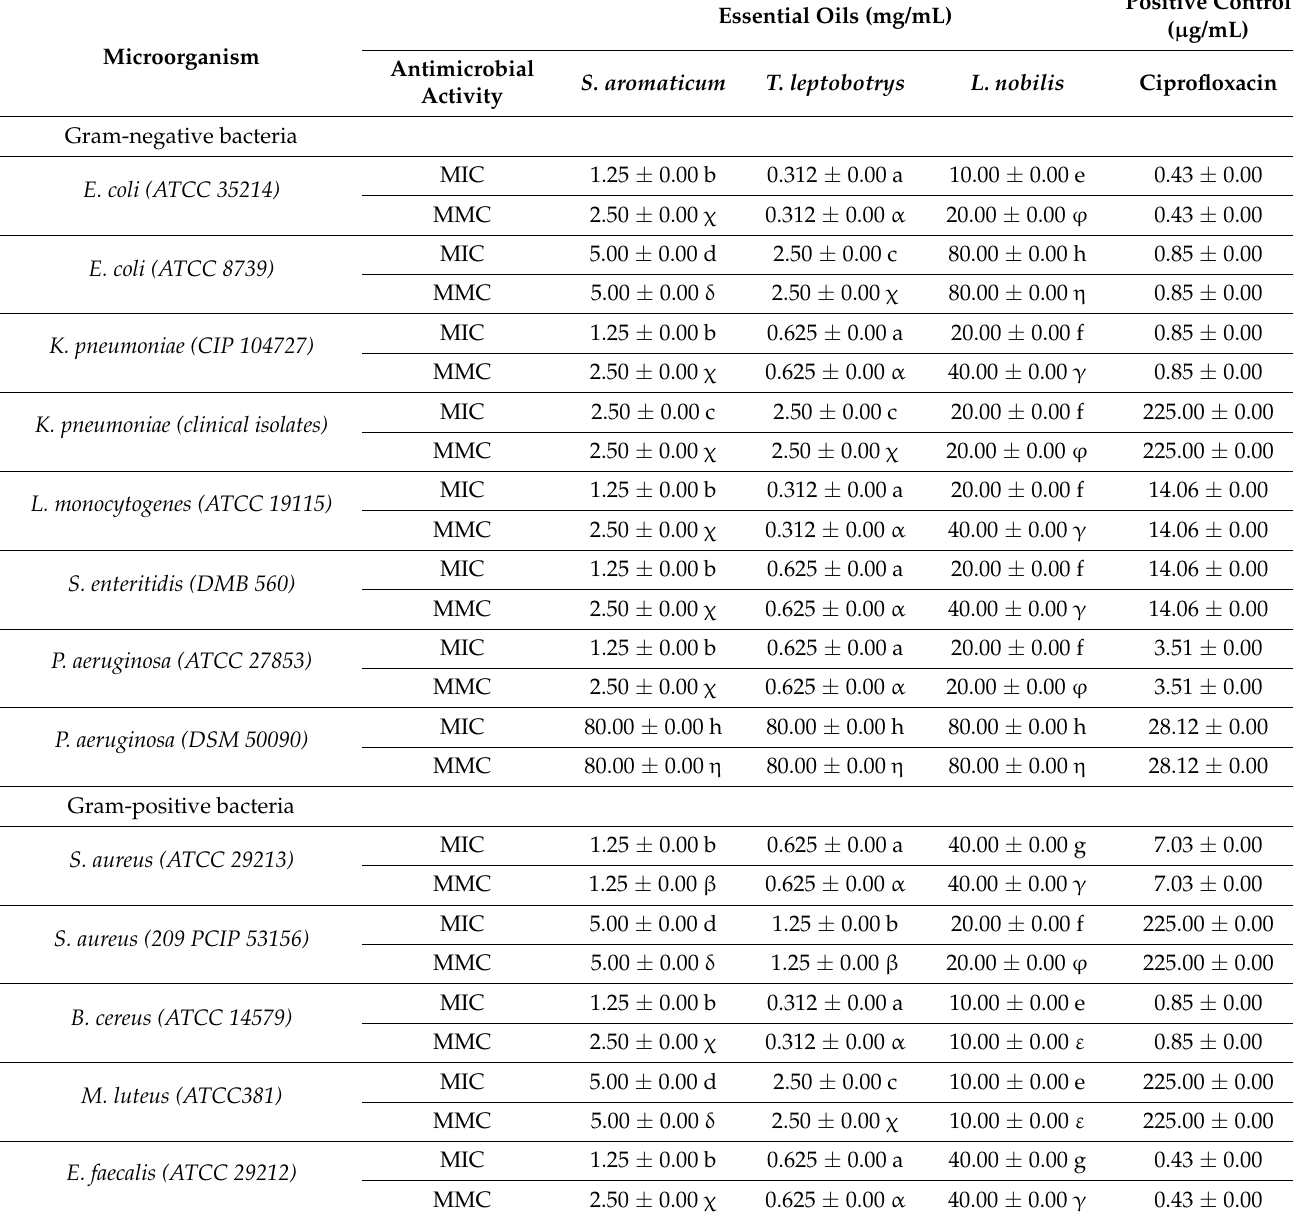
Table 5. Minimum inhibitory concentration (MIC) and minimum microbicidal concentration (MMC) against bacterial